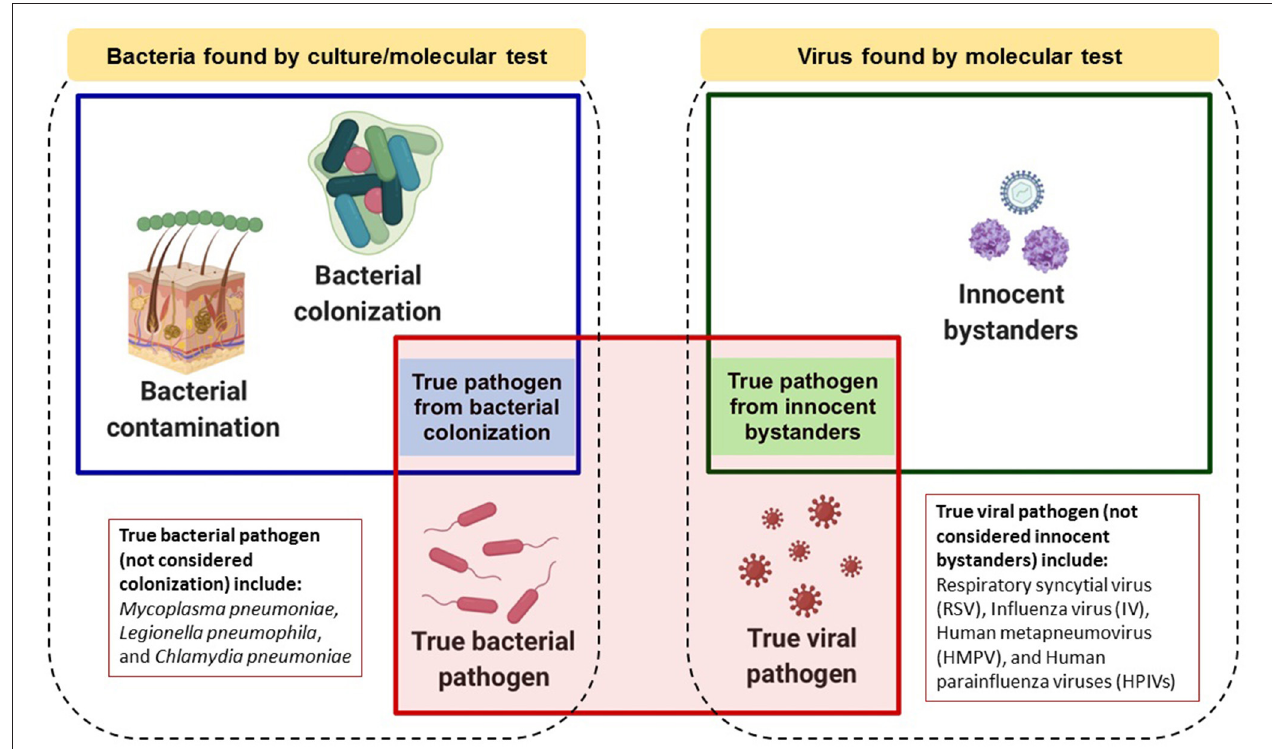
FIGURE 1 | Conceptual model of roles that bacteria or viruses detected by laboratory testing might play in childhood pneumonia. Dotted boxes encompass all bacteria or viruses found by microbiologic and/or molecular testing. Blue or green boxes represent bacteria or viruses, respectively, which could be causative pathogens. The red box represents true causative pathogens identified by the proposed “rules.” Image was created in